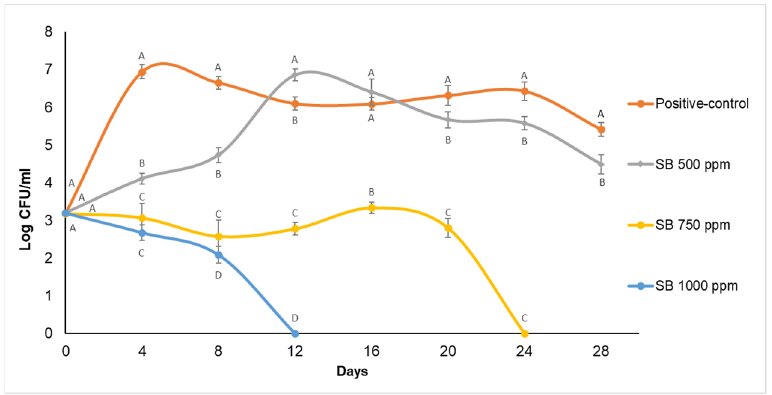
Figure 1. Effect of sodium benzoate (SB) on the growth rate of Zygosaccharomyces bailii in clear apple juice during 28 days of storage at 25 °C. Means with different letters on the same day are significantly different at p < 0.05.